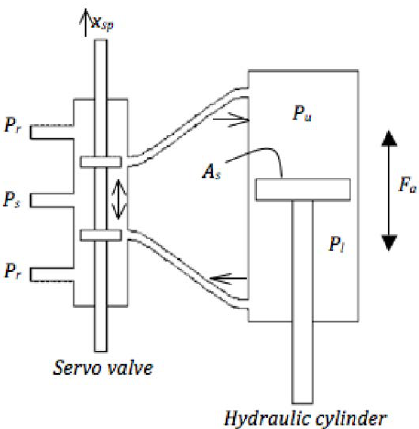
Figure 2. Schematic of the double acting hydraulic